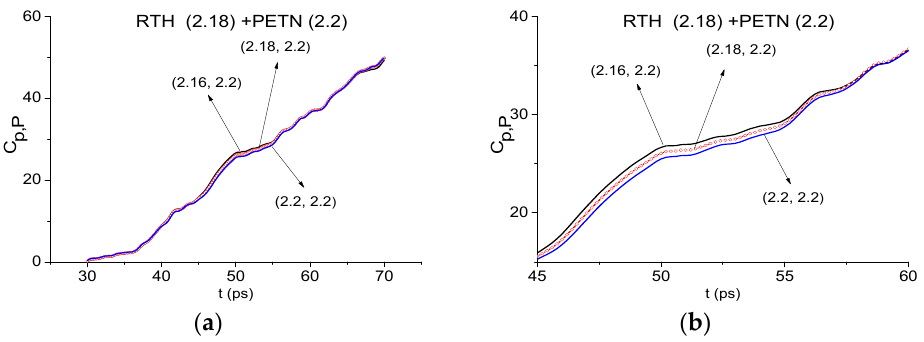
Figure 24. ICC C p , P computed for the frequency ν = 2.18 THz with PETN_Air standard signal in the time intervals t = [30, 70] ps ( a ) and [45, 60] ps ( b ). In the same manner, we show the absence of the paper and n-Si absorption frequencies in the RTH and RTP first sub-pulses spectra. To provide this, the spectra of the RTH (a), RTP (b) signals RTP spectra (a), (b) there is a minimum at the frequency ν = 2.65 THz (a), (b), which is close to the absorption frequency ν = 2.64 THz of the signal paper (see Figure 3). Two minima at the frequencies ν = 2.85 THz (a) and 2.825 THz (b) are close to the absorption frequency ν = 2.8 THz (Figure 3) of the